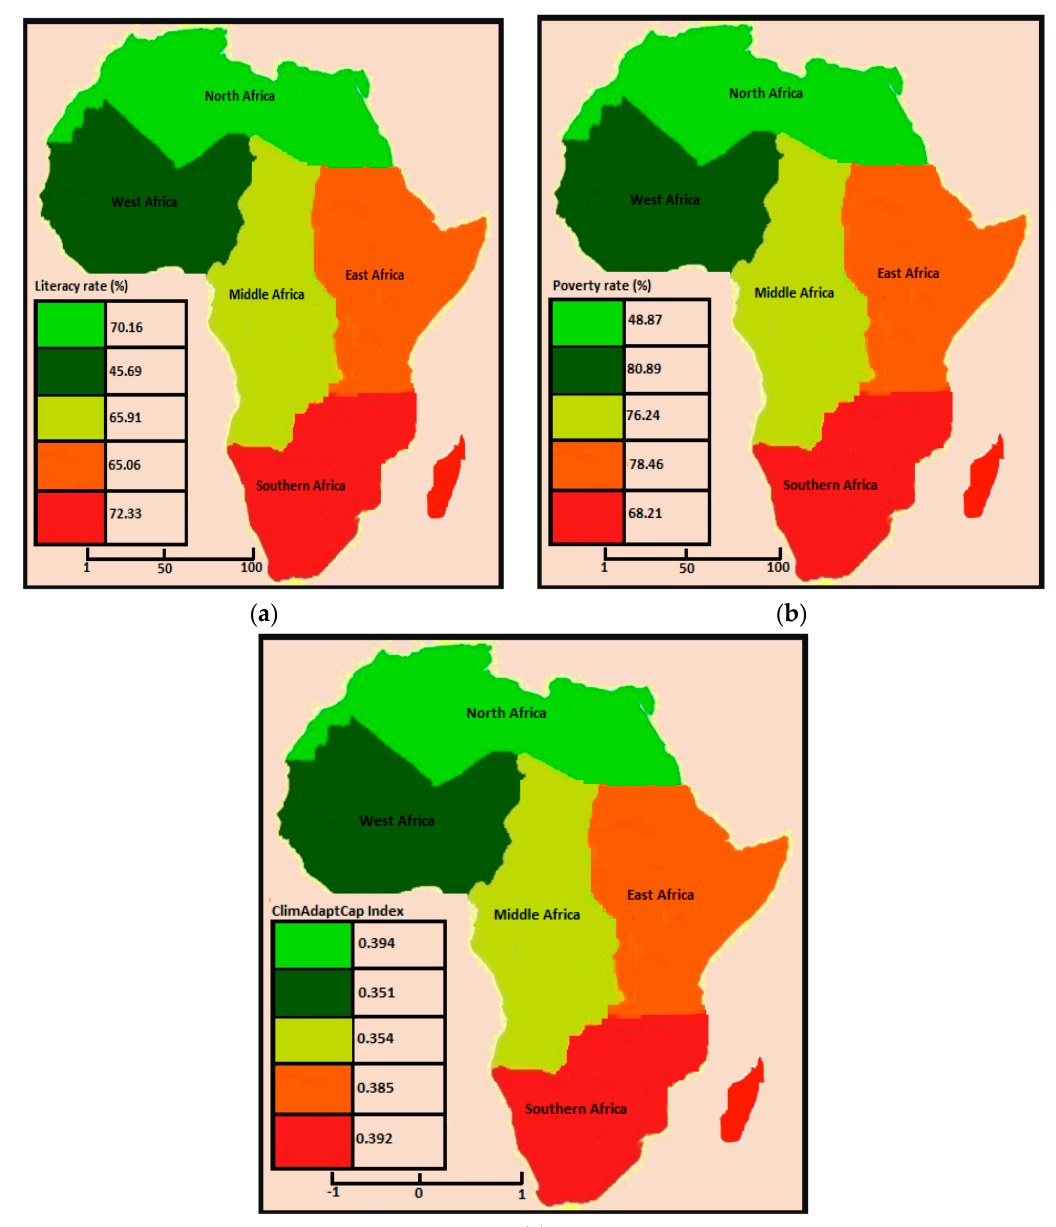
Figure 4. ( a ) Literacy Rates ( b ) Poverty Rates and ( c ) ClimAdaptCap Indexes across Africa. Source: author’s conceptualiza- tion.